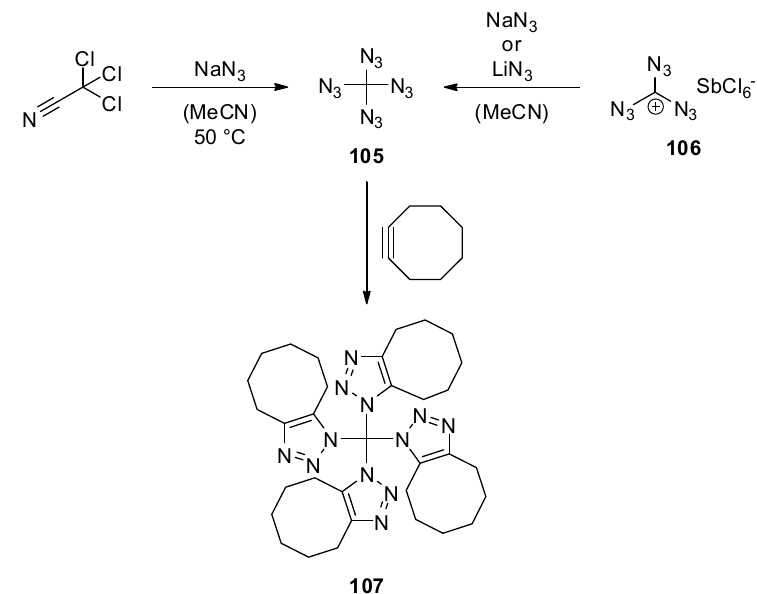
Scheme 21. Synthesis of tetraazidomethane ( 105 ).